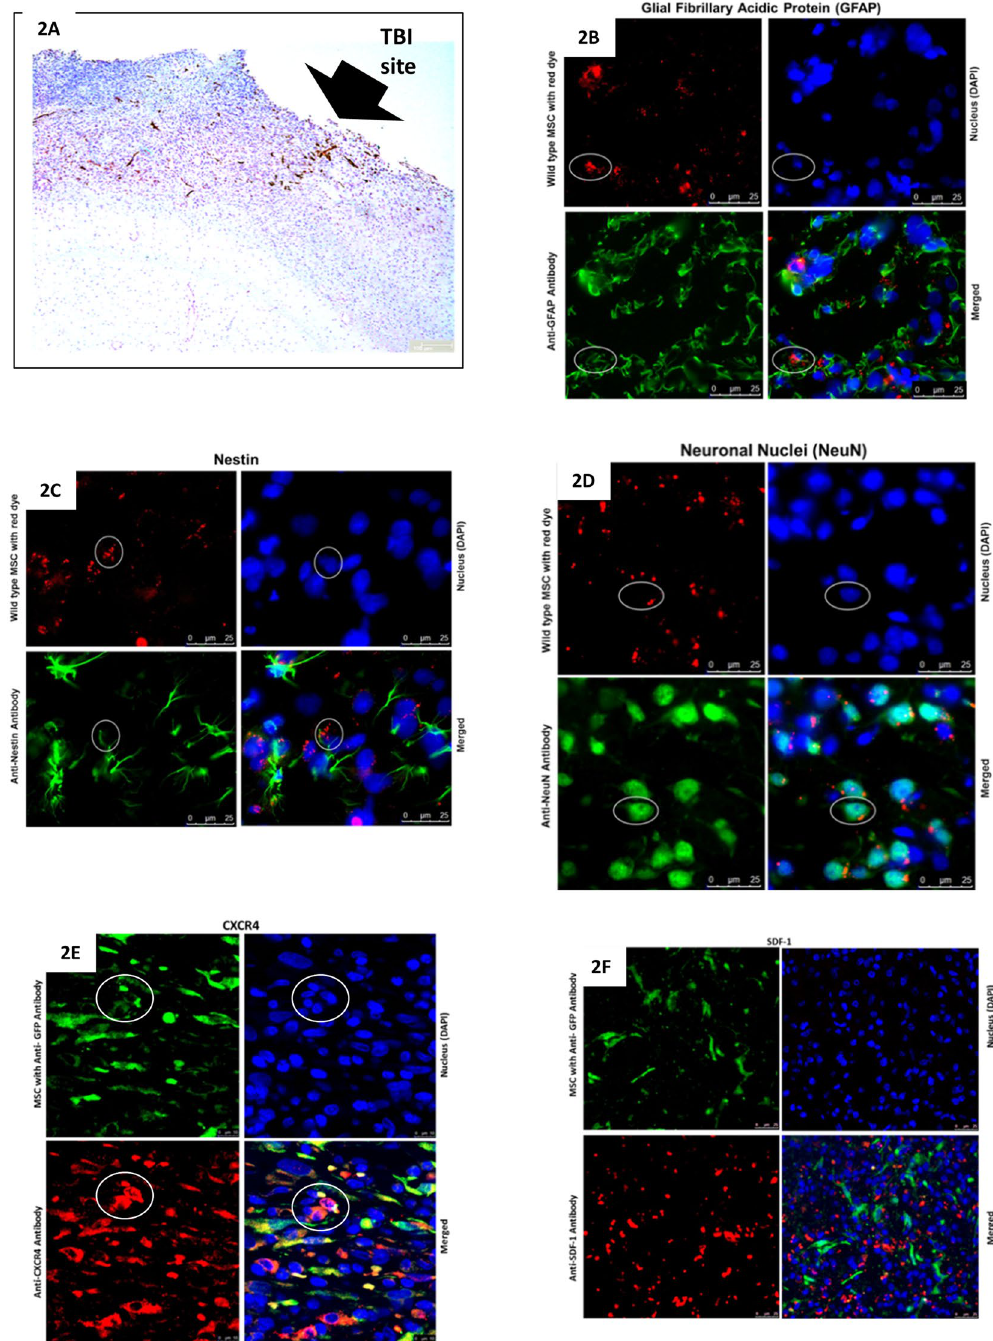
Figure 2. Fate of GFP + ve MSCs transplanted onto penumbra cortex following TBI. Few GFP + ve cells (arrows) were found in the penumbral region of TBI 3 days after topical application. ( 2A Immunohistochemistry staining IHC x200; 2B H&E x200). A TBI lesion without treatment ( 2C H&E x200). The homed MSCs which were pre-labeled with CM-DIL red fluorescence dye expressed markers of GFAP (Green) ( 2D Immunofluorescent staining IF x200); Nestin (Green) (2E IF x200) and NeuN (Green) ( 2F IF x200). CXCR4 (Red) was expressed by the homed MSCs (Green) (2 G IF x200). In the vicinity of homed MSCs (Green), the TBI penumbra expressed SDF-1 (Red) (2 H IF x200). DAPI (Blue) was used to stain the